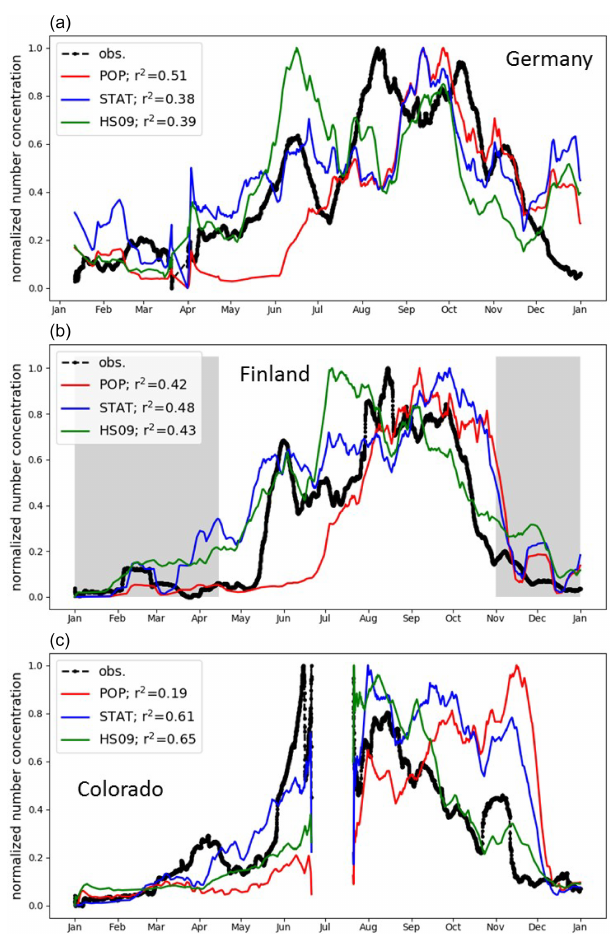
Figure 9. Normalized seasonal cycle in fungal spore and FBAP con- centrations in Germany, Finland and Colorado (see text for details). Observations (black) are compared to the simulated concentrations from the population model (red), the statistical model (blue) and the HS09 scheme (green). The shaded area indicates periods with snow cover; statistics are given for the snow-free period